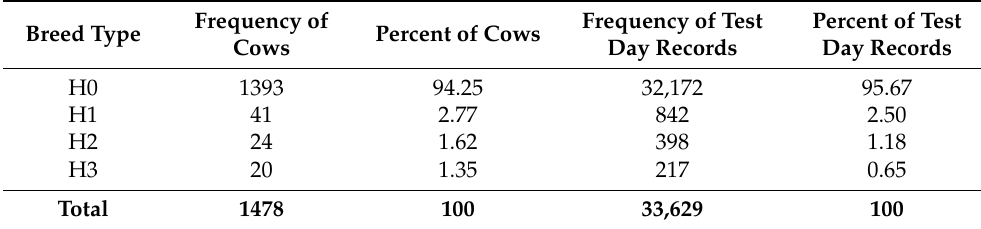
Table 3. The number of genotyped cows and the number of test day records by lactation. Frequency of Test Percent of Test Frequency of Percent of Cows Lactation Day Records Day Records Cows 01 1273 * 36.77 13,062 38.84 02 1244 35.93 11,820 35.15 03 945 27.30 8747 26.01 Total 1478